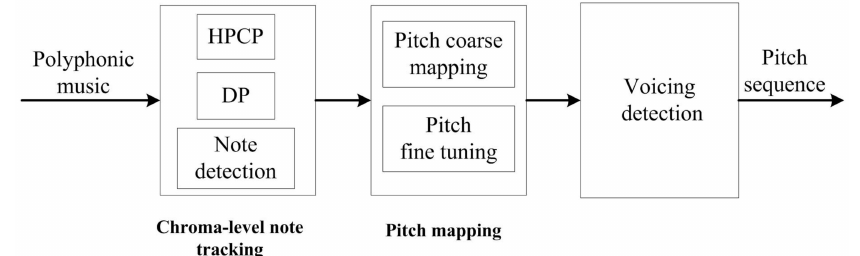
Figure 1. Block diagram of the chroma-level note tracking and pitch mapping-based